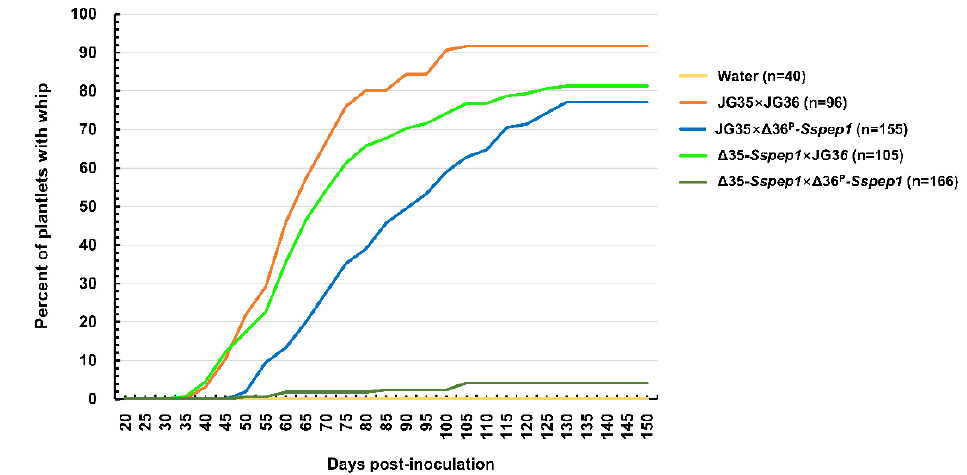
Figure 4. Progression of whip development induced by Sspep1 deletion mutants. Sugarcane plantlets were inoculated with combinations of wild-type strains and/or Sspep1 -deletion mutants at the concentration of OD = 1.0. The ‘n’ is the total number of plantlets